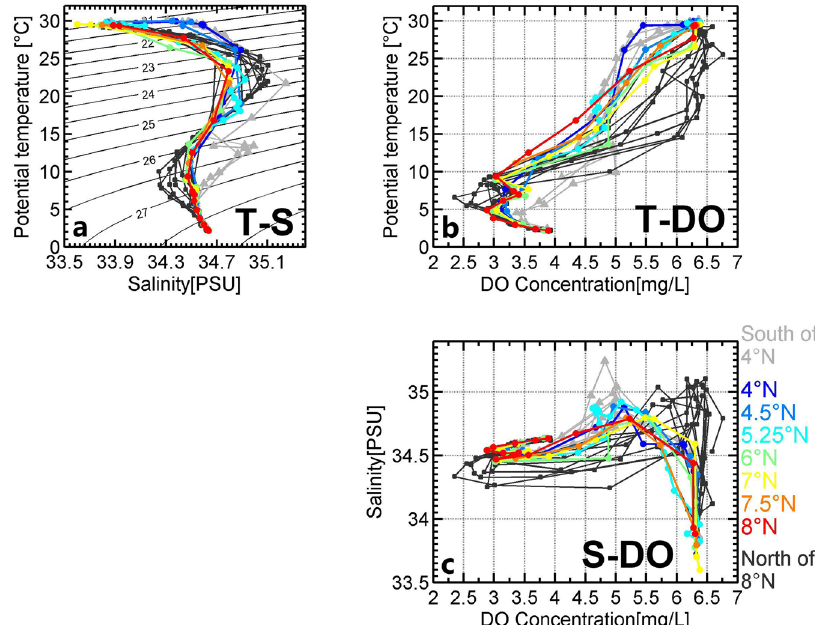
Fig. 7 Water mass properties from hydrographic observations. Relations of a potential temperature versus salinity (T – S), b potential temperature versus dissolved oxygen concentration (T-DO), and c salinity versus dissolved oxygen concentration (S-DO) from the hydrographic data collected during the cruise. Light gray lines represent stations south of 4°N, black lines represent stations north of 8°N, and colored lines represent stations between 4°N and